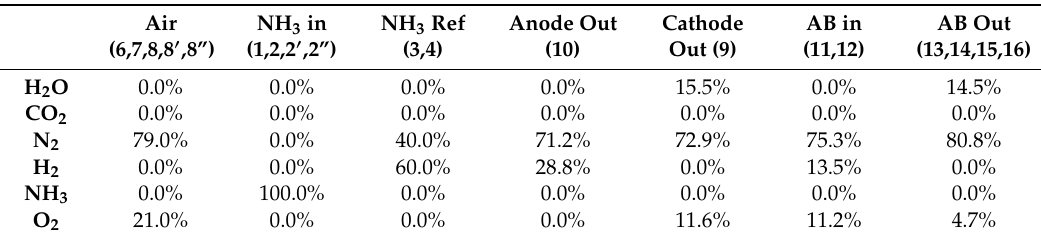
Table 4. Gas composition of all mixtures.